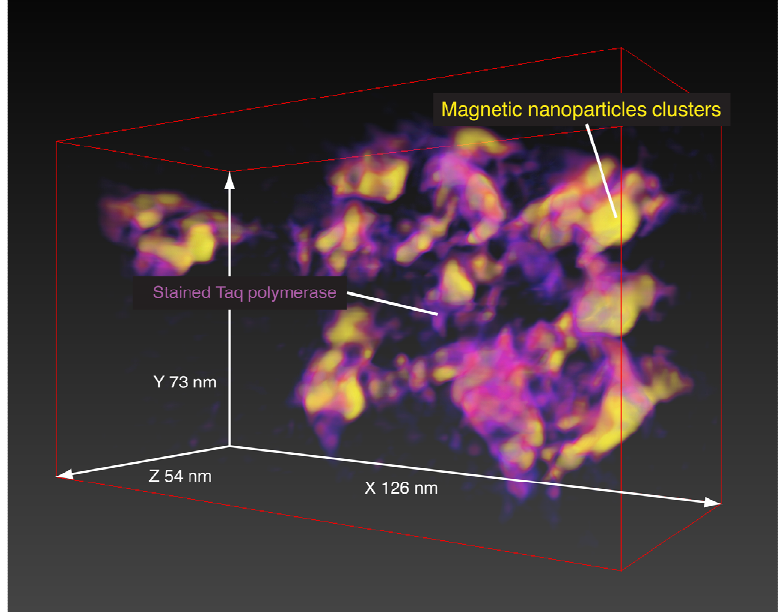
Figure 7. TEMT 3D reconstruction image of EMG607 magnetic nanoparticle clusters heat-treated in PCR thermal cycles with 0.6 μ L of Taq